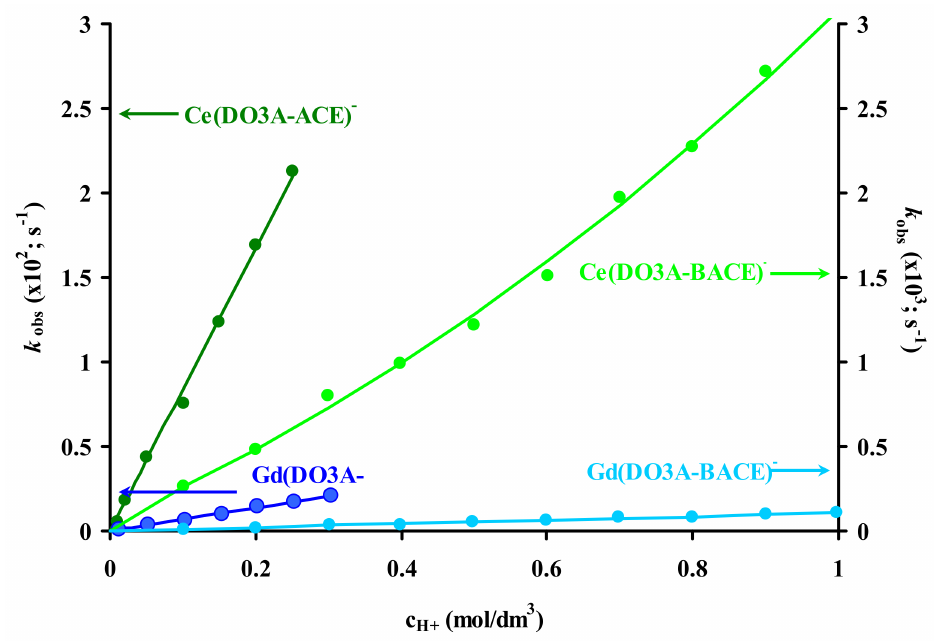
Figure 4. Dependence of the dissociation rate constants ( k obs ) on the H + concentration in the dissociation of Ce(DO3A-ACE) − (green), Gd(DO3A-ACE) − (blue), Ce(DO3A-BACE) − (light green), and Gd(DO3A- BACE) − (light blue). The lines correspond to the fit according to Equations (5) and